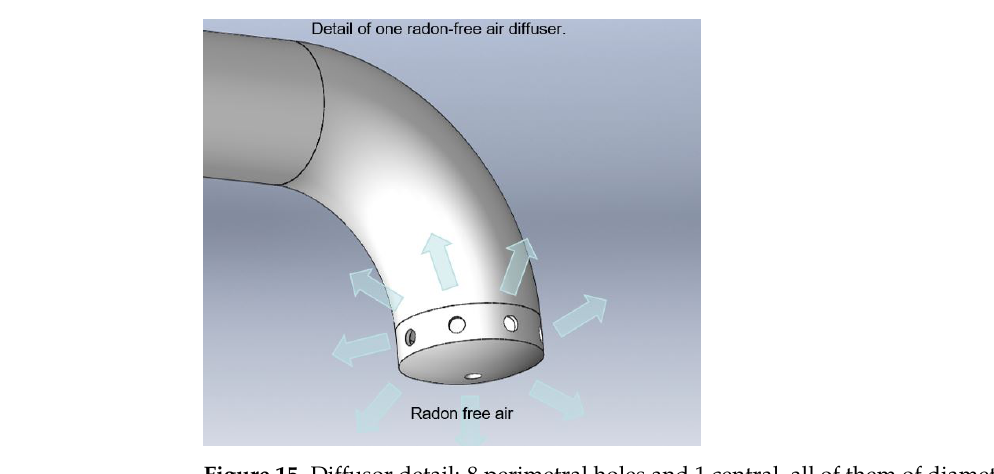
Figure 15. Diffusor detail: 8 perimetral holes and 1 central, all of them of diameter d = 5 mm.